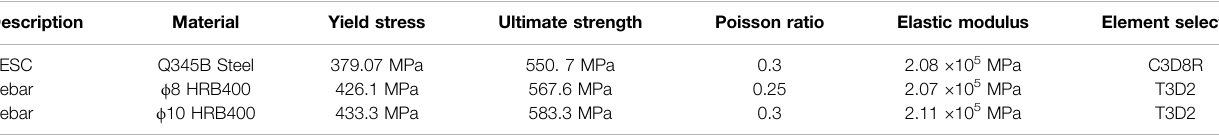
TABLE 5 | Material properties in fi nite element model. Steel material